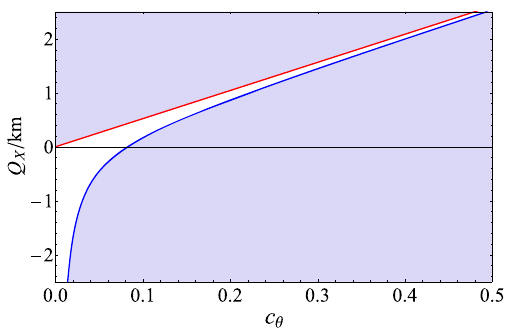
Fig. 4 The allowed parameter region (white region) for the charge Q X of the Sun and and c θ corresponding to Mercury. The red line and blue curve correspond to the upper and lower bounds given in Eq.